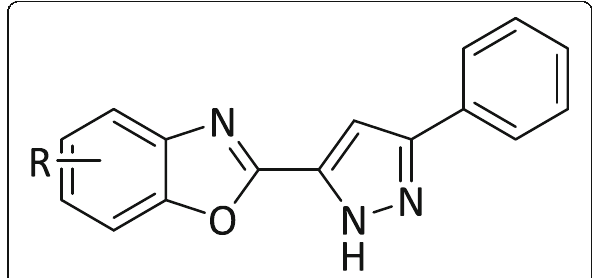
Fig. 25 Benzoxazole pyrazole